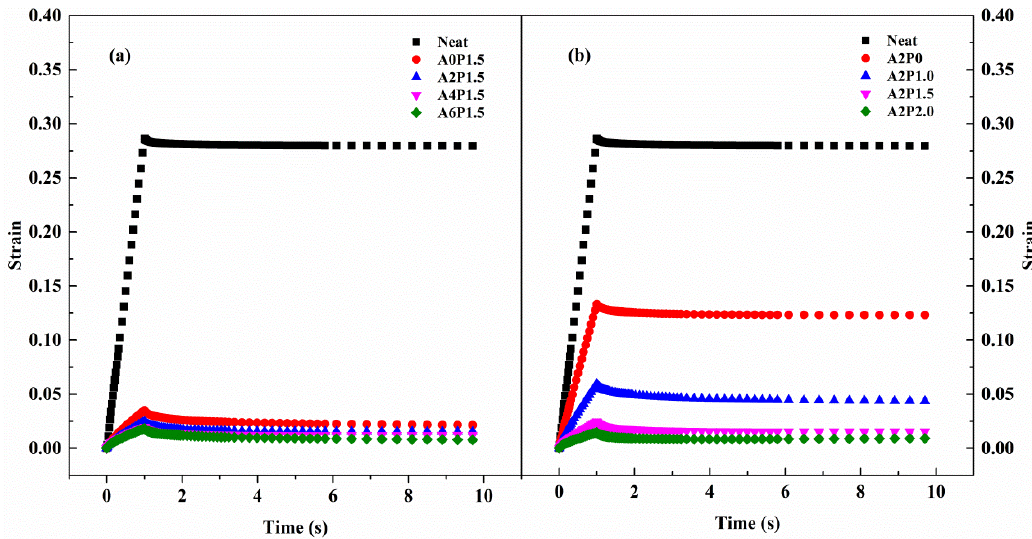
Figure 9. A creep–recovery cycle of the composite modified binder at 0.1 kPa and 60 °C: ( a ) composite modified binders with various contents of APAO; ( b ) composite modified binders with various contents of PPA.